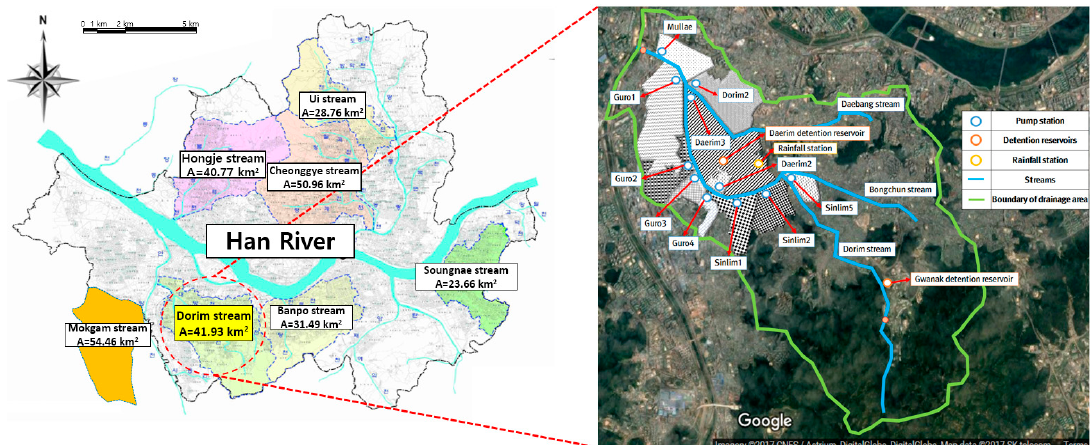
Figure 6. Description of the target area (Imagery © 2017 Centre National d’Etudes Spatiales/Astrium, DigitalGlobe, DigitalGlobe, Map data © SK telecom).